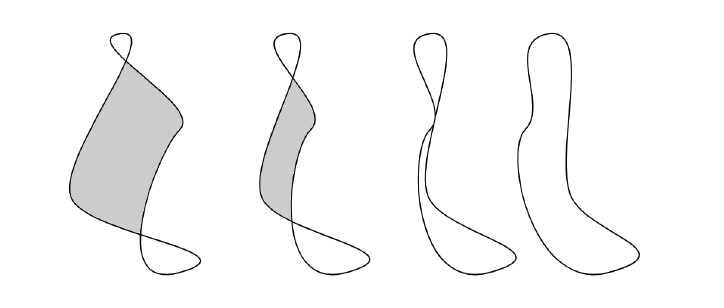
Figure 4.2: An illustration of the Whitney